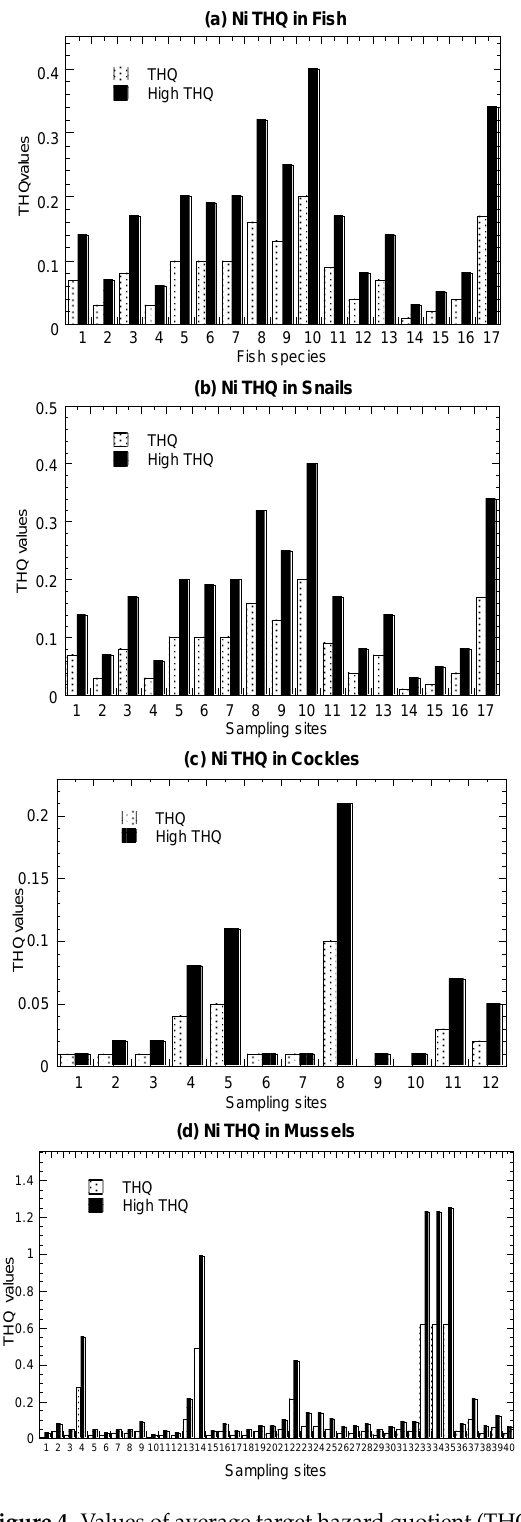
Figure 4. Values of average target hazard quotient (THQ) and high-level target hazard quotient (High THQ) of nickel (Ni) in the ( a ) marine fish (1 – 19), ( b ) mangrove snail Cerithidea obtusa (1 – 17), ( c ) cockle Anadara granosa (1 – 12), and ( d ) marine mussel Perna viridis (1 – 40) cited from Yap et al. [35]. Note: The THQ value > 1.00 is likely to induce harmful health consequences [63]. The high-level consumers (2 times of consumption rate of average-level consumers) are indicated by High.